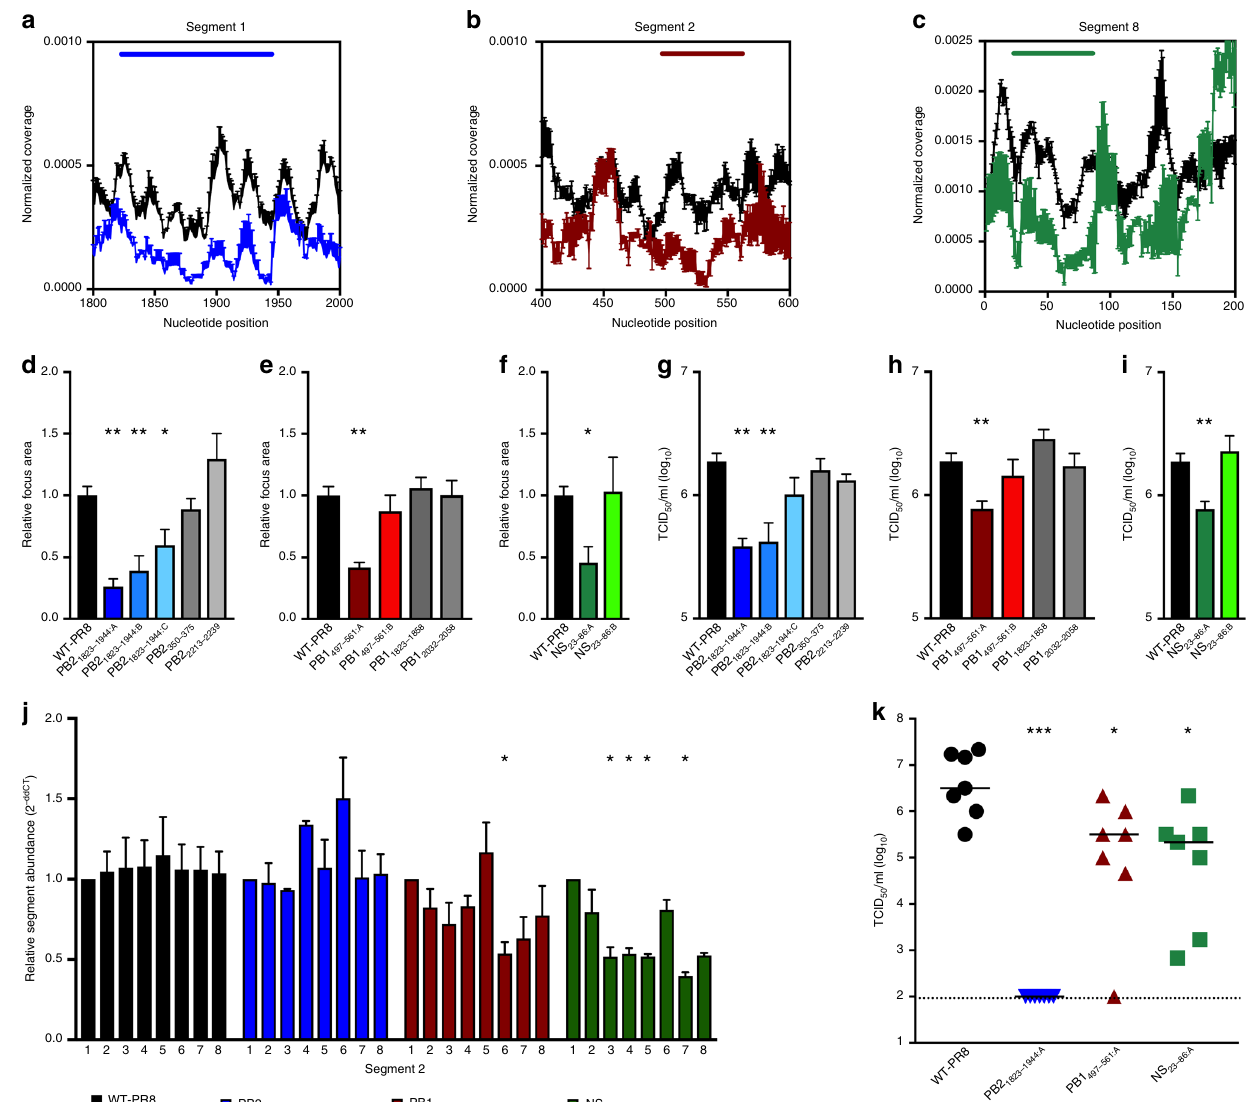
Fig. 4 Synonymous structural mutations in low-NP-binding regions in Segments 1, 2, and 8 attenuated virus replication and genome packaging. a – c Segment 1 ( a , blue line), 2 ( b , red line), and 8 ( c , green line) low-NP-binding regions de fi ned by PAR-CLIP analysis. Normalized coverage ± s.e.m. was determined for each nucleotide in the PAR-CLIP (blue, red or green symbols) and RNA-seq (black symbols) libraries ( n = 4 each). d – f Relative focus area of WT-PR8 and segment 1, 2, and 8 mutant viruses. Results are the average focus area + s.e.m. of 3 experiments per virus ( > 60 foci each). Statistical signi fi cance was determined by one-way ANOVA with a multiple comparisons correction (Kruskal – Wallis test). ** P < 0.01; * P < 0.05. g – i Viral titer (TCID 50 ml − 1 ) of 4 HA-units of WT-PR8 and mutant virus. Results are the average of three viral titrations and two HA assays per infectious virus titration (TCID 50 assay and HA titration experiments, mean + s.e.m). Statistical signi fi cance was determined by unpaired t test. ** P < 0.01; * P < 0.05. j Relative abundance of genome segments in puri fi ed WT or mutant viruses. All segments were compared to segment 1 (PB2) vRNA and normalized to the average of WT-PR8 values using the 2 -ddCt method 22 . Bars represent the mean of 3 – 6 independent virus preparations + s.e.m. and statistical signi fi cance was determined by one-way ANOVA with a multiple comparisons correction (Kruskal – Wallis test). * P < 0.05. k C57BL/6J mice were inoculated with 10 3 TCID 50 in 30 µ L. Lungs were collected 48 hpi, homogenized, and titered. Each dot is a single mouse and the line is the median. Dotted line in k represents the limit of detection and statistical signi fi cance was determined by one-way ANOVA with a multiple comparisons correction (Kruskal – Wallis test). (*** P < 0.005, * P <